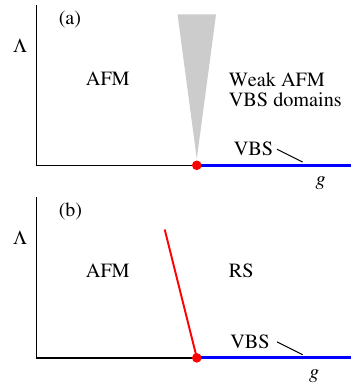
FIG. 5. Schematic ground-state phase diagrams of models such as the J - Q model in the presence of disorder. Here, Λ represents a disorder strength, and g is a tuning parameter existing also in the pure system (e.g., g ¼ Q=J in the J - Q model). In the pure model, Λ ¼ 0 , there is a DQC point (red circles) separating the AFM and VBS phases. The VBS is destroyed, breaking up into domains for any Λ > 0 . In (a), which applies to the model with site dilution, there is no phase transition vs g when Λ > 0 , only a crossover (indicated by the wedge) between the standard AFM state and a state with finite VBS domains in which weak AFM order forms among localized effective moments. In (b), which applies to the case of random coupling constants, there is a true continuous quantum-phase transition between the AFM and RS phases for at least some range of Λ > 0